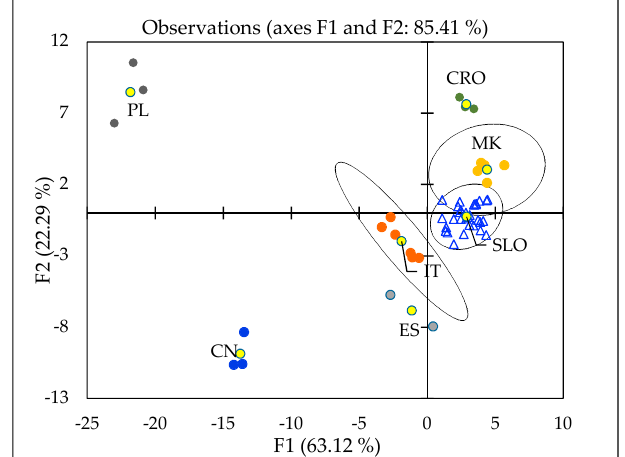
Figure 6. Projection of discriminant analysis (DA) of truffle samples regarding their geographical origin: CN (China), CRO (Croatia), ES (Spain), IT (Italy), MK (North Macedonia), PL (Poland), SLO (Slovenia). Yellow markers refer to centroids.